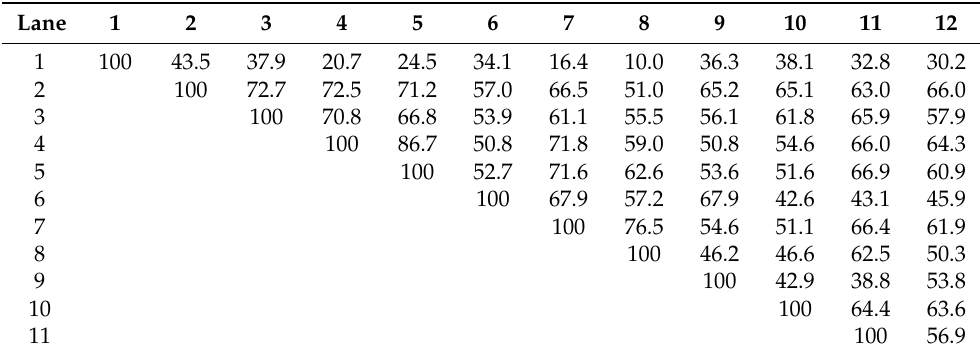
Table 3. Calculation method dice coefficient of similarity matrix with the same treatments and different times